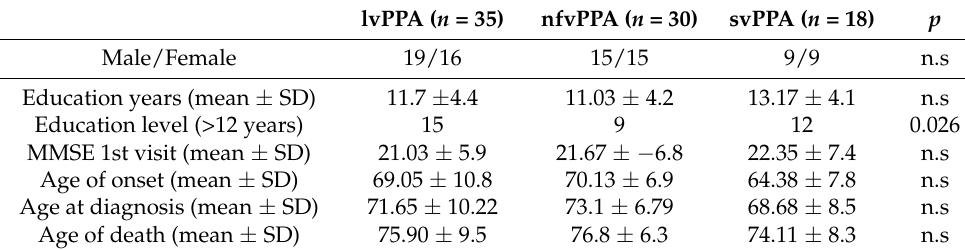
Table 1. Patient